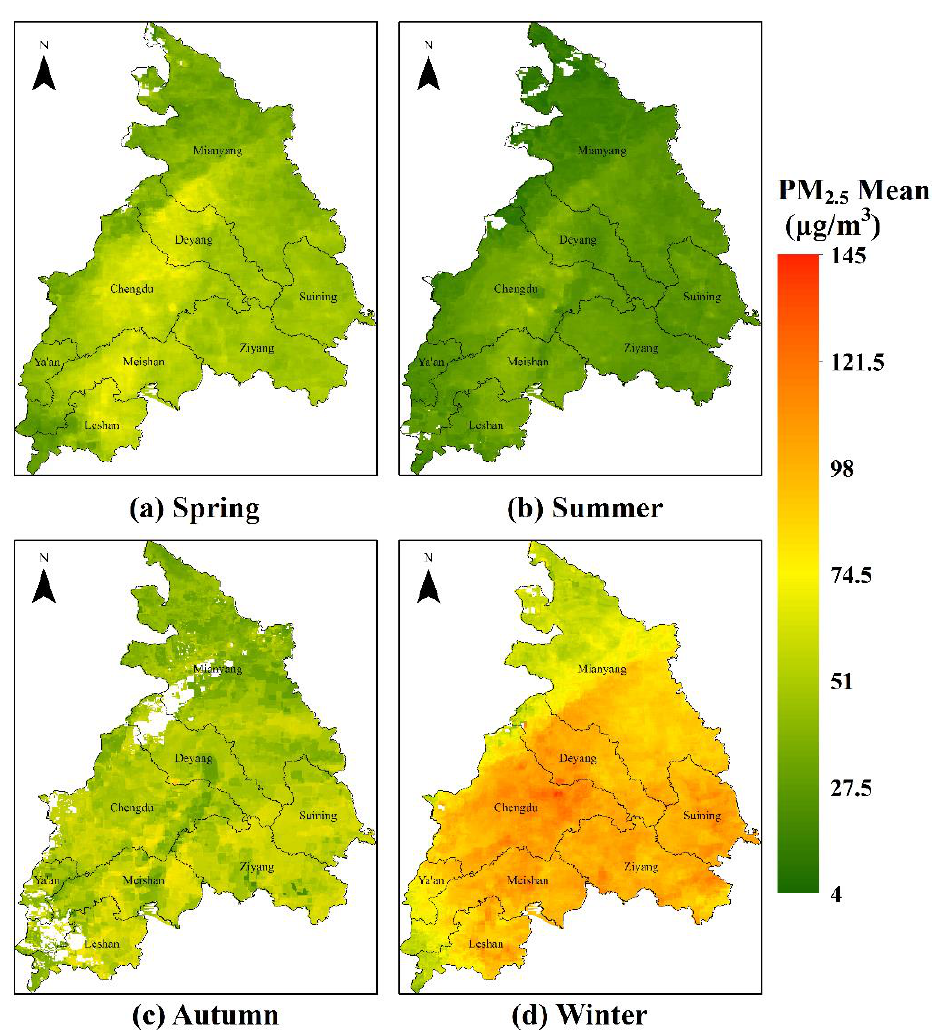
Figure 6. Maps of seasonal mean PM 2.5 concentration ( µ g / m 3 ) calculated with daily estimation for the year of 2015. ( a ) Spring, ( b ) summer, ( c ) autumn, ( d ) winter. The white blank areas indicate missing value due to lack of MAIAC AOT data. The boundaries of eight cities area shown in black